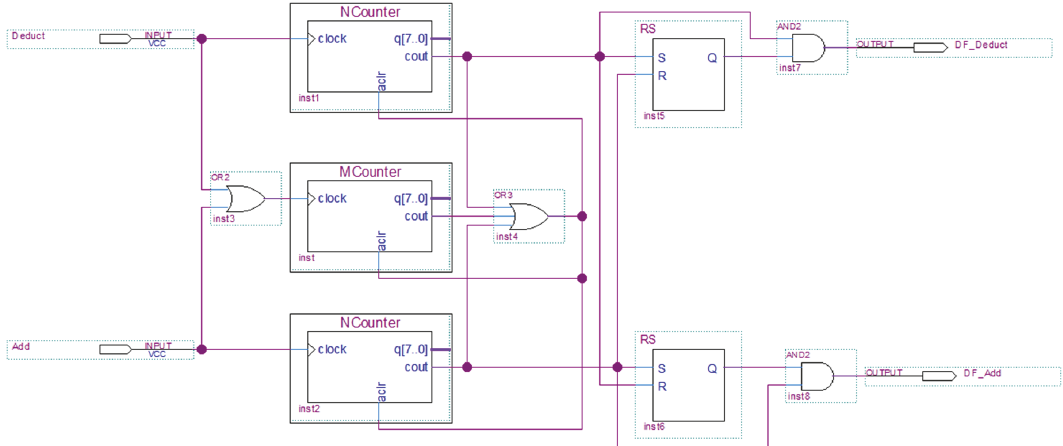
Figure 12: Schematic of digital filter